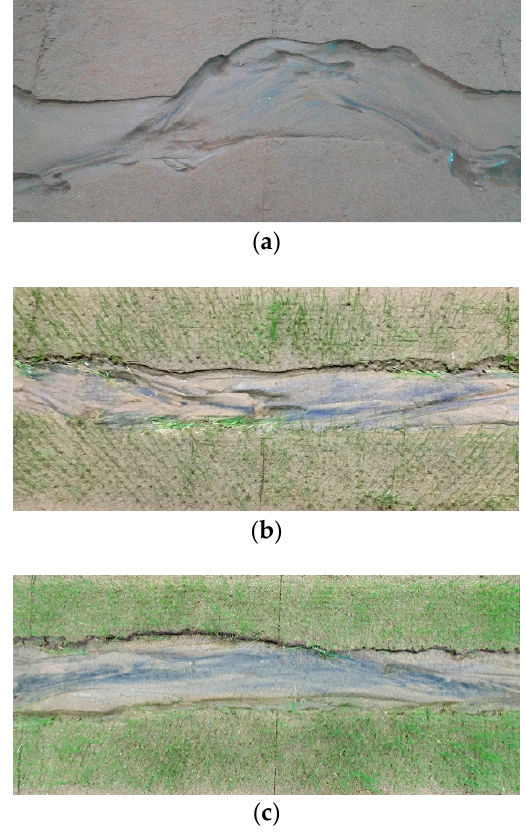
Figure 8. Bed morphology of the 1.5–2.5 m reach at the stable time: ( a ) no vegetation cover, ( b ) riparian vegetation coverage of 40% in bilateral riparian areas and ( c ) riparian vegetation coverage of 80% in bilateral riparian areas.